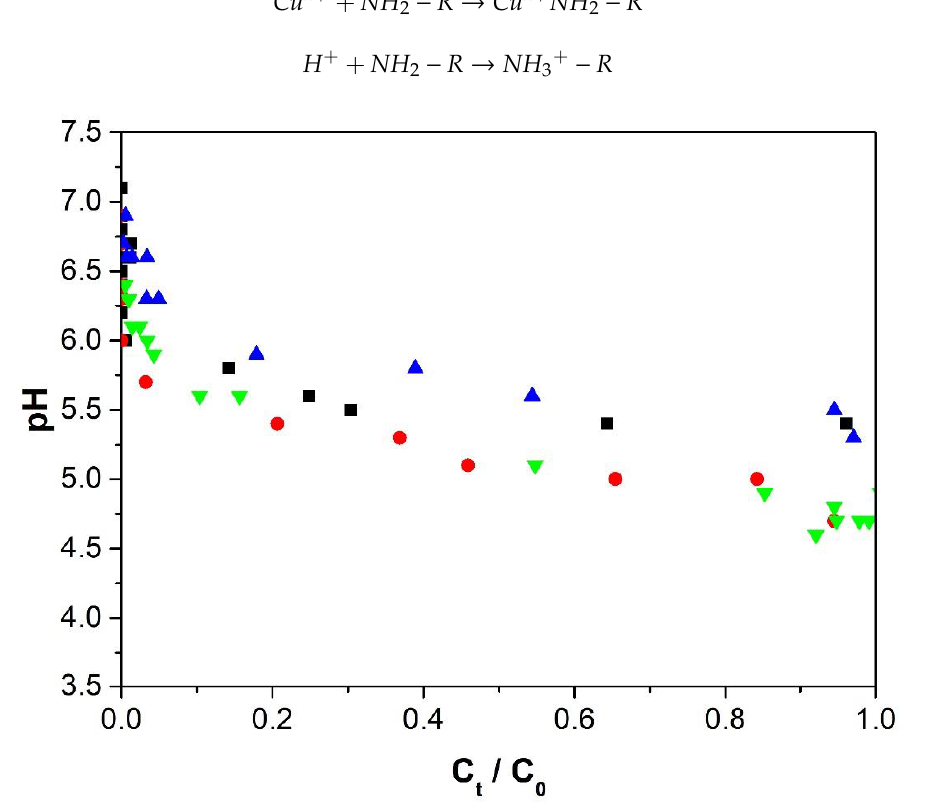
Figure 9. pH of the effluent solution using a flow rate of 50 mL/h, initial concentration of 50 mg/L, and pH of 5.0. Alg-Ch: ■ 33 cm, ▲ 13 cm column height;. Alg-ChS: ● 33 cm, ▼ 13 cm column height.